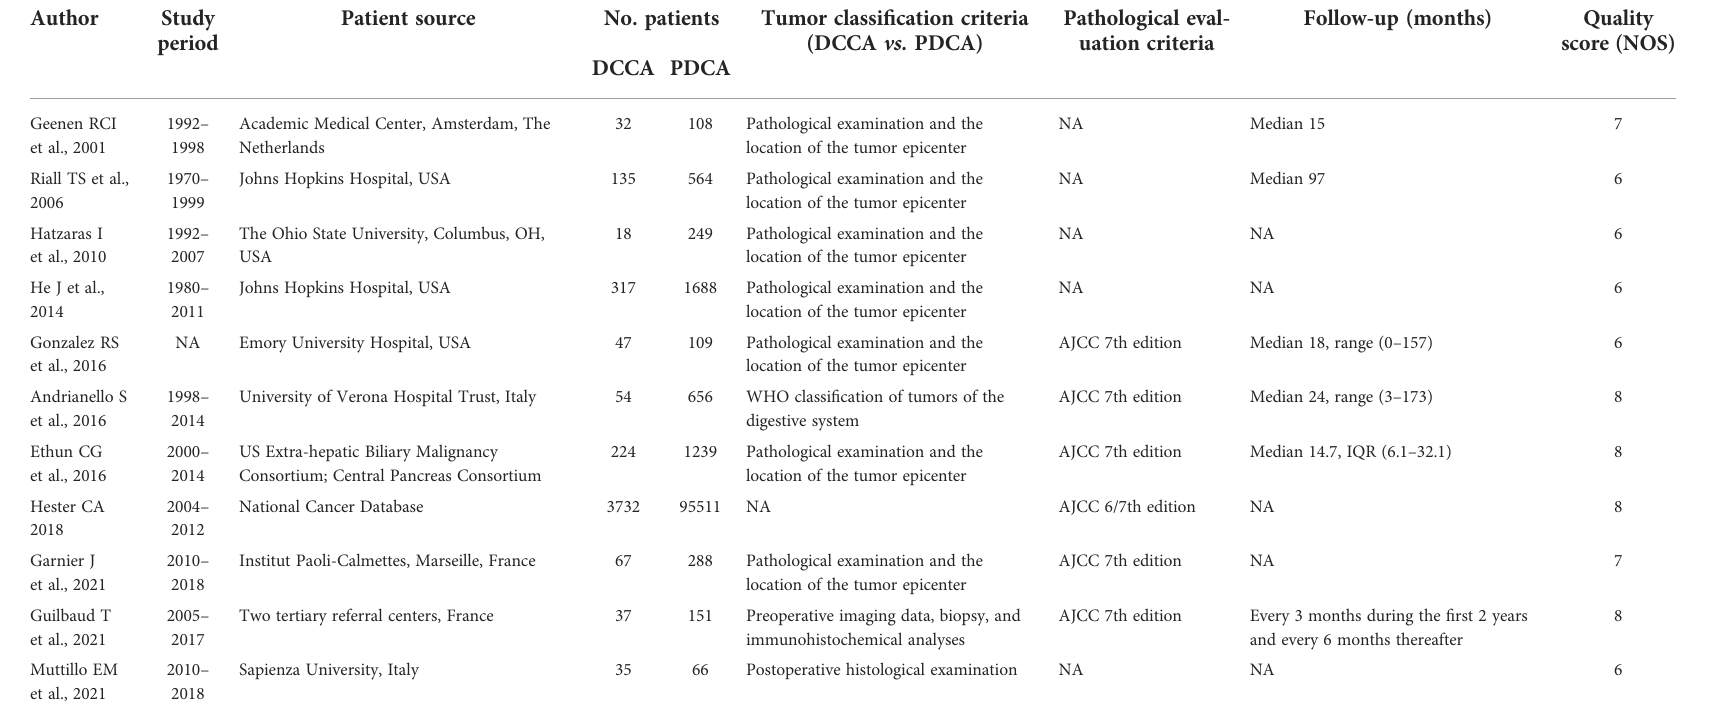
TABLE 1 Baseline characteristics of all studies